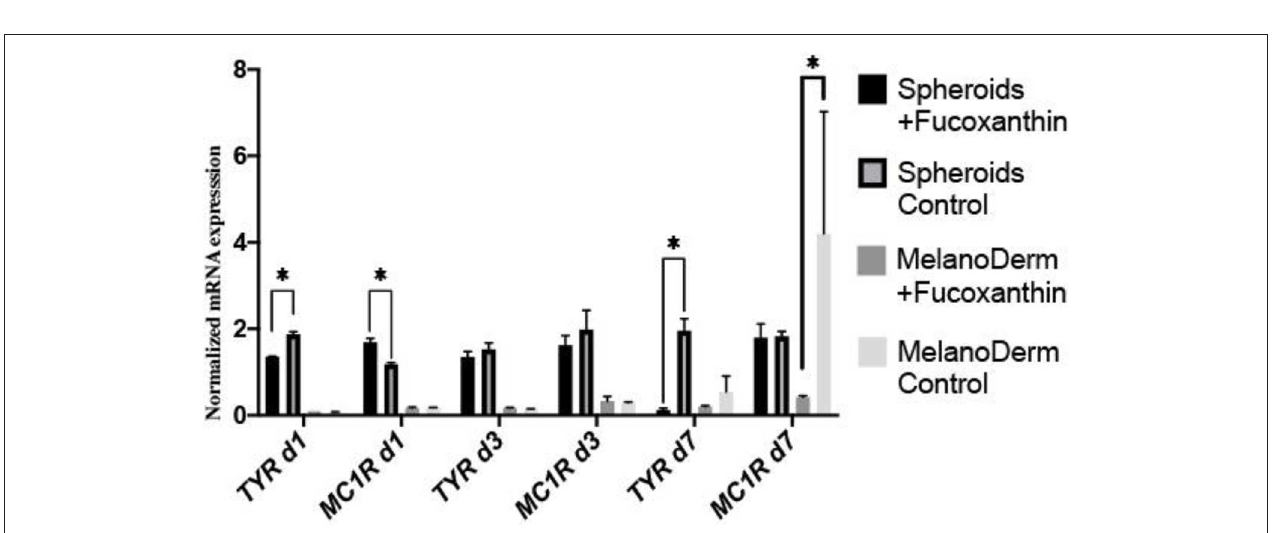
FIGURE 6 | Real-time PCR analysis of TYR and MC1R expression in MelanoDerm TM tissue equivalents and spheroids from human melanocytes on Days 1, 3, and 7 in the presence of fucoxanthin and in the control group with growth medium. * p < 0.05 for two-way ANOVA assay and multiple t